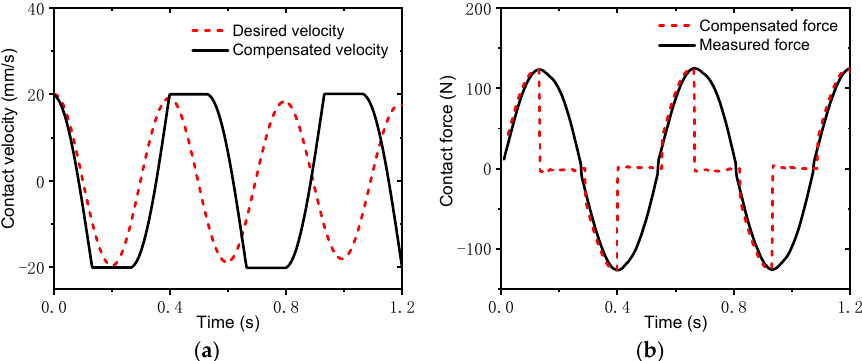
Figure 12. Estimates of contact velocities and forces in virtual collisions. ( a ) Velocities. ( b ) Forces.